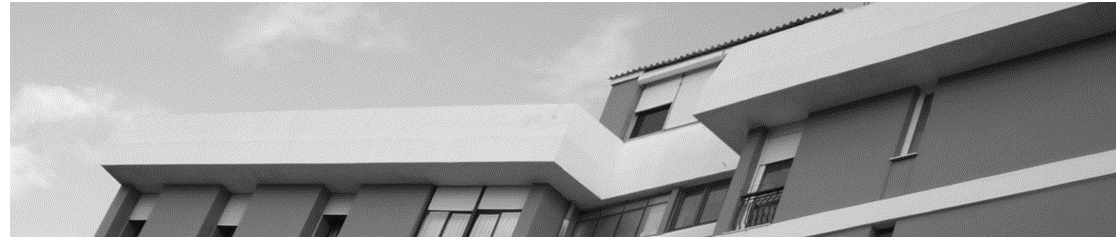
Figure 25. Detail of the cornice.